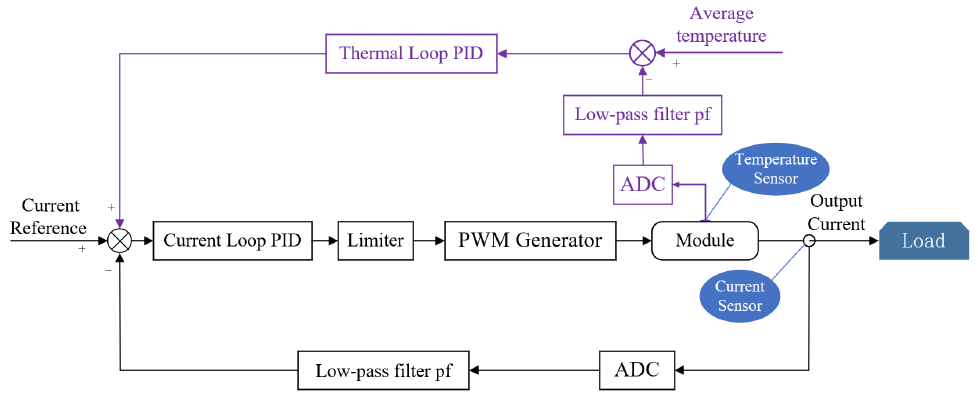
Figure 10. The control process of the module.